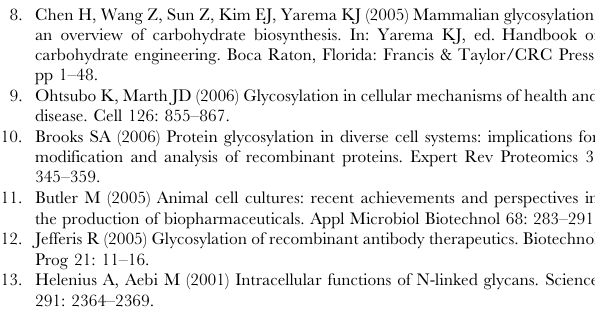
Figure S2 Reactions between glycans belonging to different